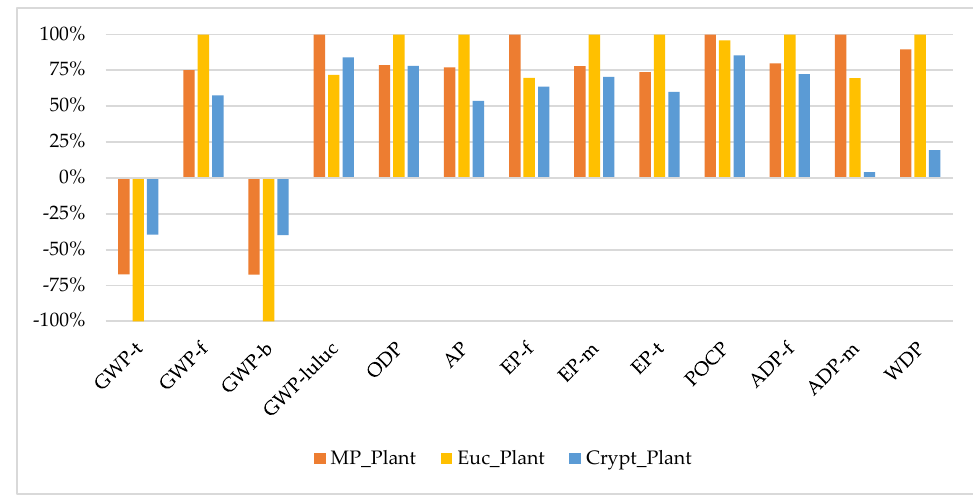
Figure 1. Relative core environmental impacts per cubic meter of roundwood.